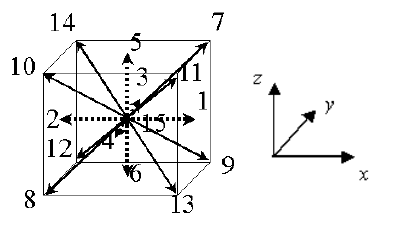
Figure 3. The D3Q15 model used in the lattice Boltzmann method for 3D